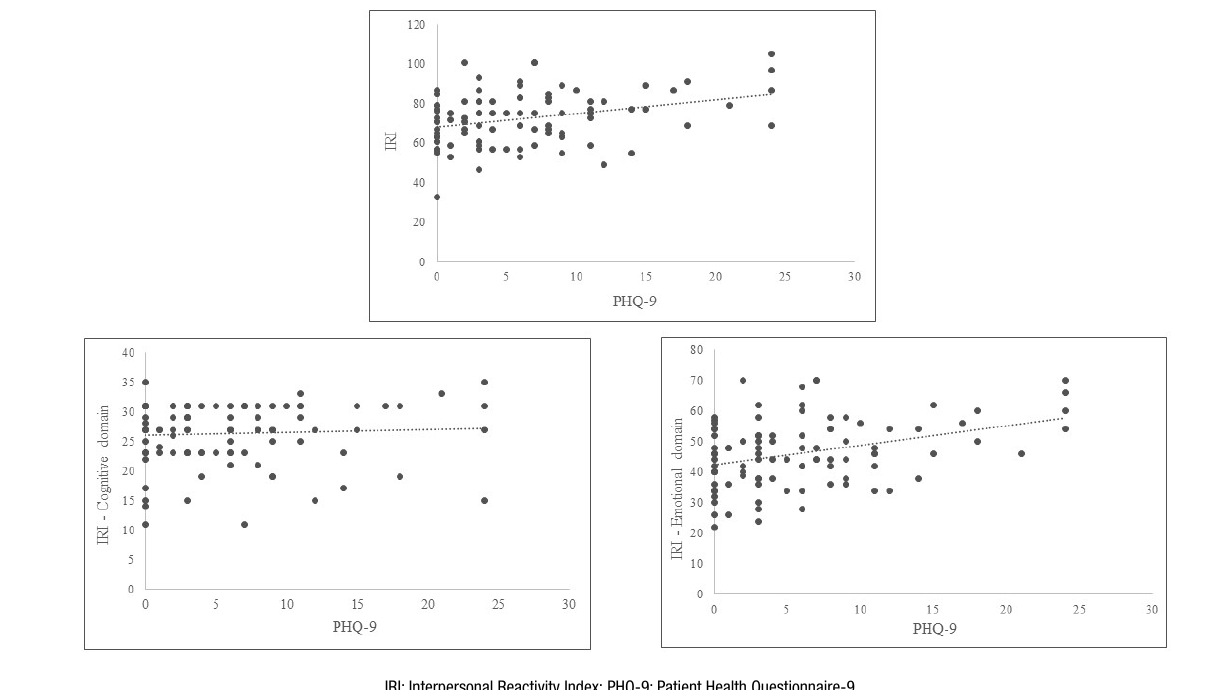
Figure 1. Scatter plot of correlation between PHQ-9 scores and the total IRI; between PHQ-9 and the emotional domain; and between the PHQ-9 scores and the cognitive